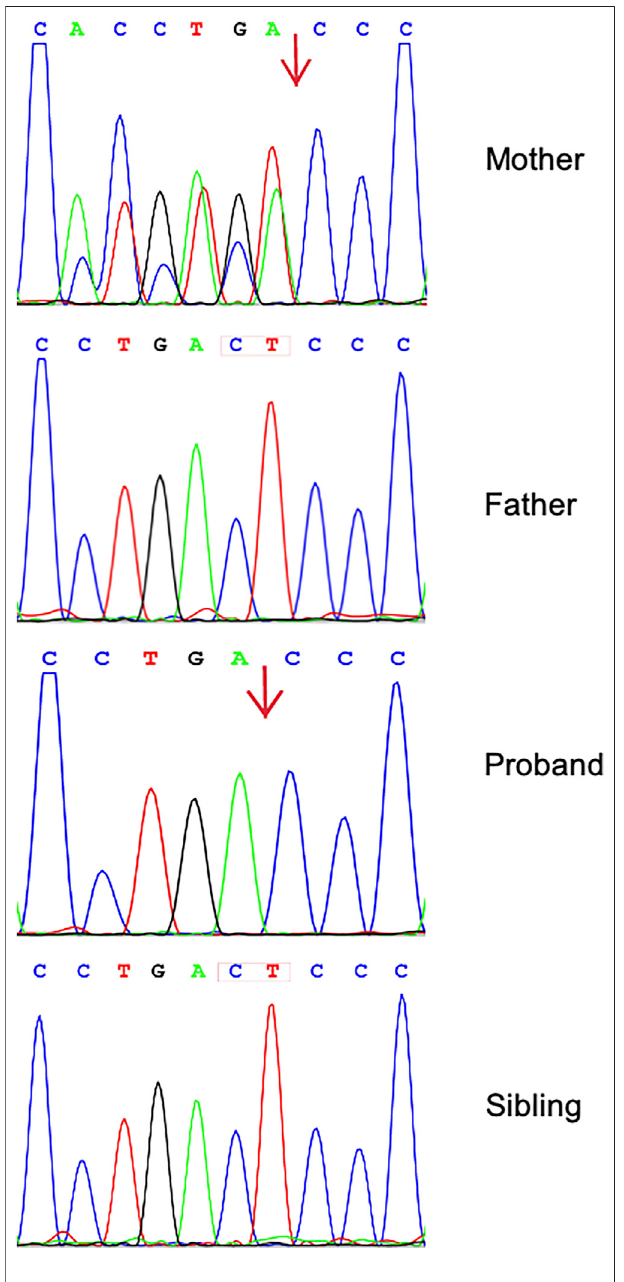
FIGURE 1 | Sequence analysis of CNTN2 gene from the family. Chromatograms showing that the mother is heterozygous for c.2873_c.2874delCT (p.Thr958Thrfs*17). The proband shows a homozygosity of the mutation; his father and little brother have wild-type